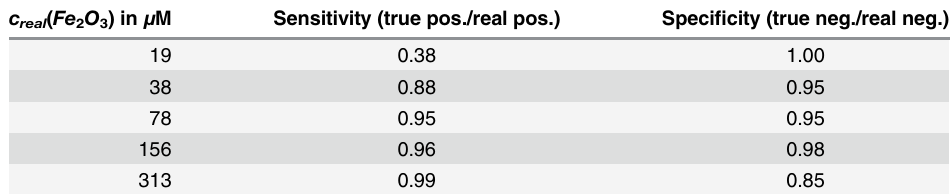
Detection limit. In previous work, the R (cid:1) detection limit was reported as 70 cells per mm 3 2 for a uniform agarose background [10], and the unambiguous identi fi cation of iron oxide background. In nanoparticles was not possible [11] in an environment with a non-uniform R (cid:1) 2 contrast, our new localization method relies on multiple features characteristic for the presence of iron oxide and thus provides a lower detection limit of 30 cells per mm 3 (Figs 4 and 5). Concentration estimation. From the R (cid:1) values of the voxels classi fi ed as containing iron 2 oxide, we calculated the iron oxide concentration, based on relaxation rate measurements per- formed on an iron oxide nanoparticle dilution series. Estimated values were accurate within 10% on average. Voxels with the highest concentration, however, were underestimated by 19% on average (Table 1), because the signal intensity at the longest TE (11.34 ms) was too low, and therefore too close to the background signal intensity, for a reliable exponential fi t for comput- ing R2 (cid:1) .